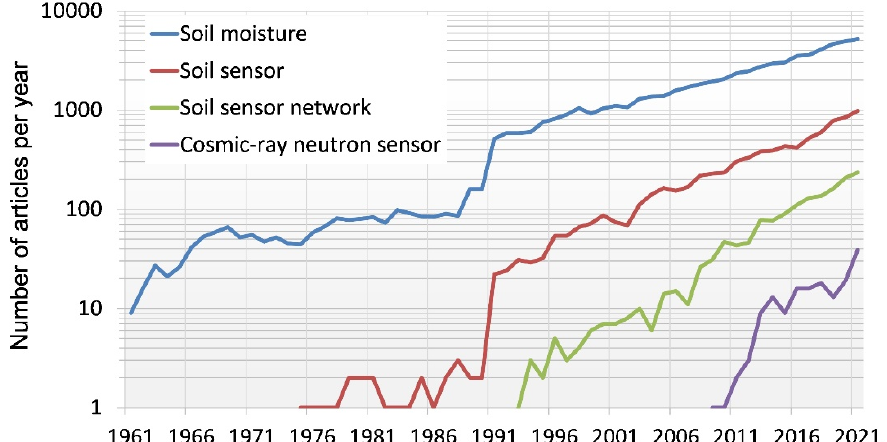
Figure 2. Number of articles on soil moisture, soil sensors, soil sensor networks, and cosmic-ray neutron sensors per year since 1961.